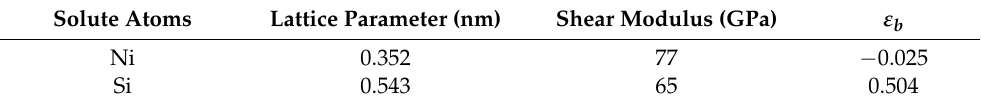
Table 3. Strain energy of different solute